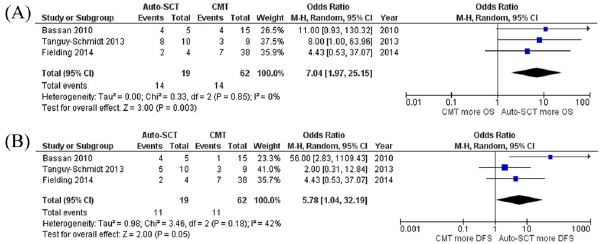
Fig 4. Forest plot of the meta-analysis of auto-HSCT versus CMT only. (A) OS rate (B) DFS rate. Abbreviations : Auto-SCT Autologous stem cell transplantation, CMT Chemotherapy only, DFS Disease-free survival, OS Overall surviva.